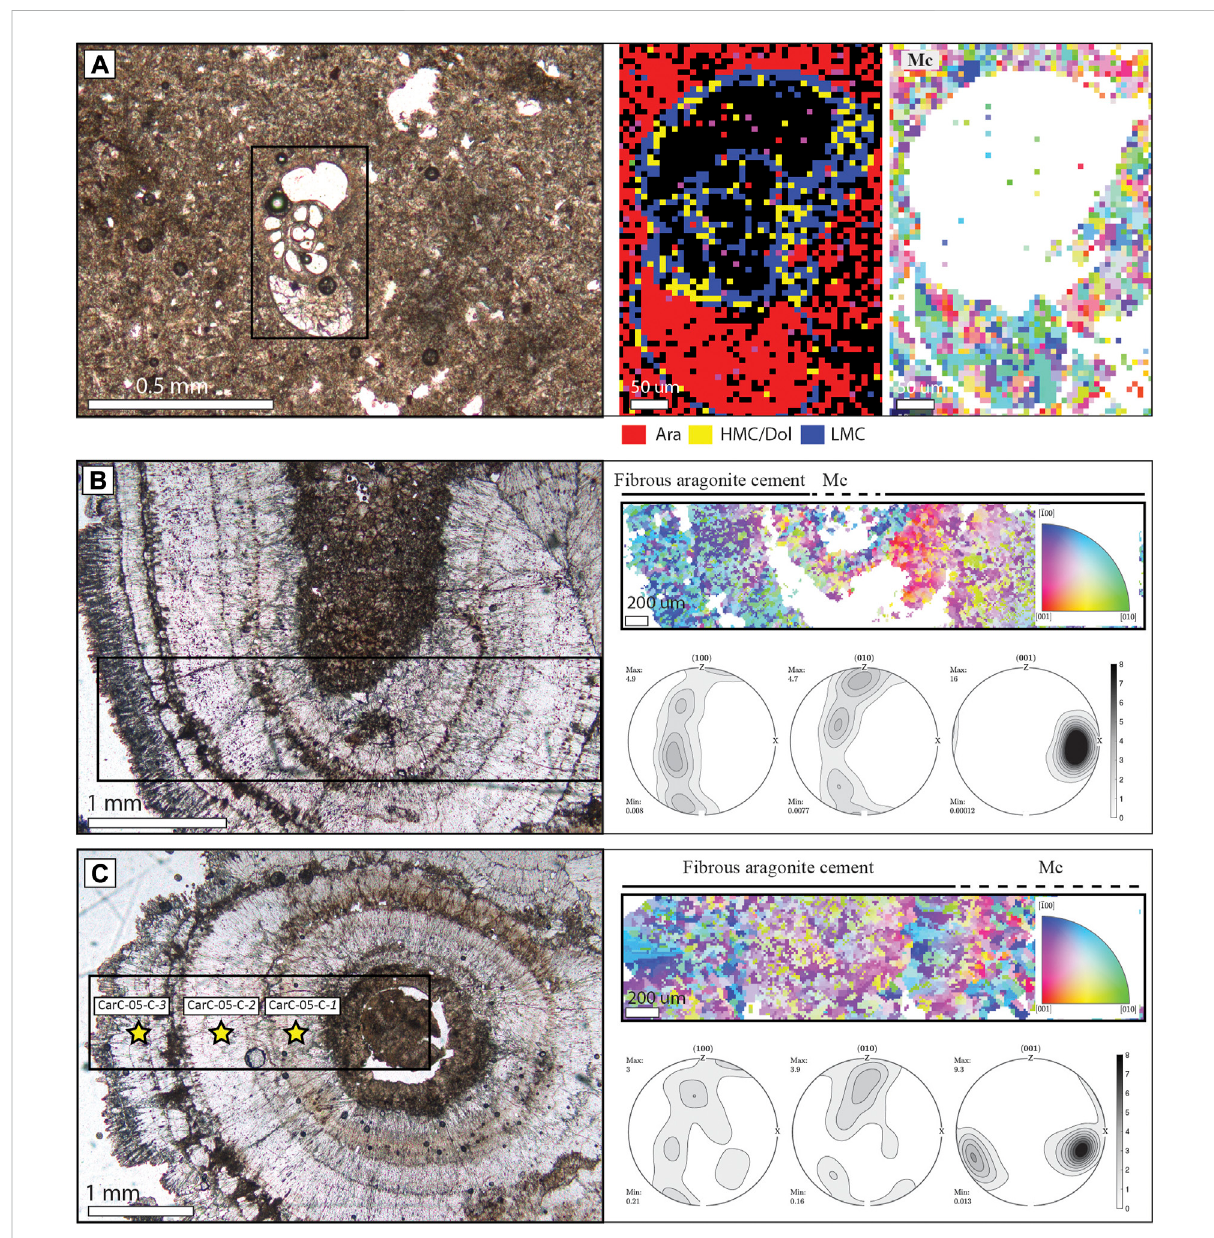
FIGURE 4 Thin section micrographs and EBSD phase and crystal orientation maps of areas marked in Figure 3B. Orientation maps help visualize crystal directions normal to the plane of observation using the color key in the insets. Orientations are also plotted as stereographic projections in the pole fi gures. (A) Micrite microfacies engul fi ng a foraminiferal test. The EBSD phase map clearly shows a dominant aragonitic mineralogy for the microcrystallinecarbonate,withlowmagnesiumcalcitecorresponding tothetest.Somelowmagnesiumcalcite/dolomiteisfoundonthetest. Microcrystalline carbonate shows randomly-oriented microcrystals in the orientation map. (B) Fibrous aragonite cements showing variable orientation of the individual crystals passing from a preferred [ − 100] crystal direction on the left side of the section to [001] on the right. Cement phases are separated by dissolution surfaces. (C) Isopachous cements showing a rather constant crystal orientation close to [ − 100] direction. The micro-drilled subsample locations are showed with starts. Mc= microcrystalline